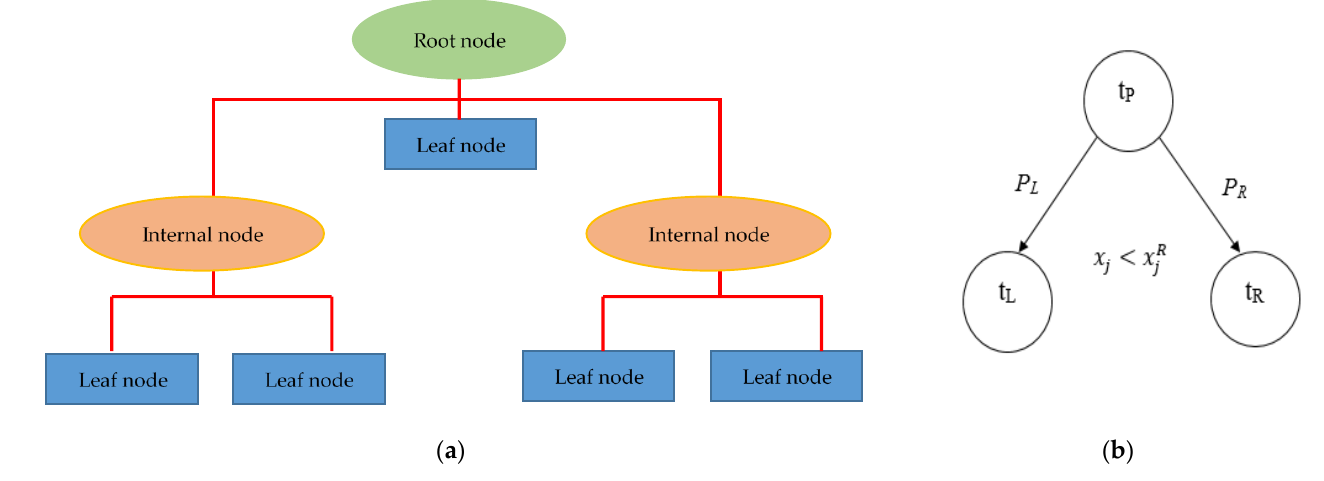
Figure 11. Decision tree attributes ( a ) and division process ( b ).